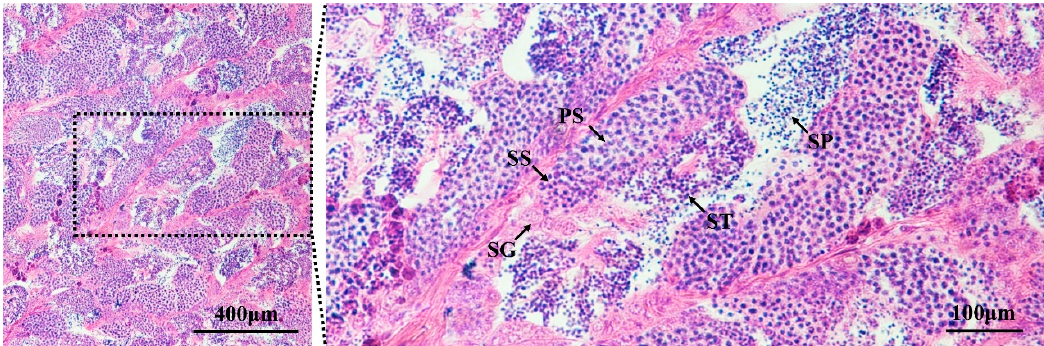
Figure 2. Developmental stage identification of testes by histological analysis. The results